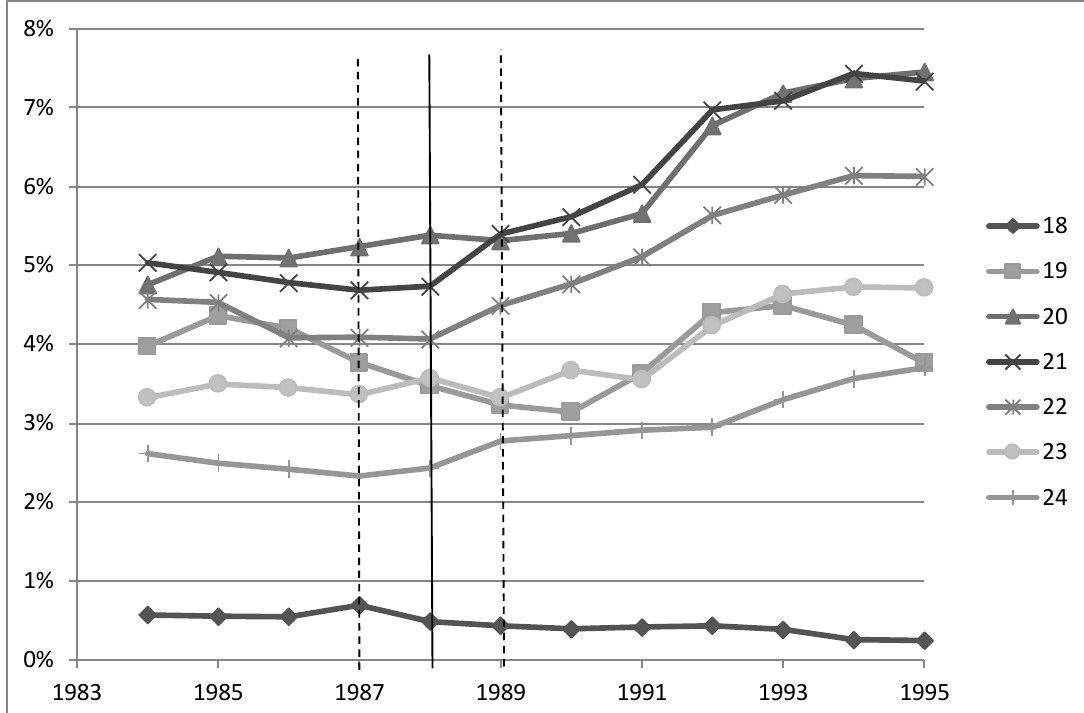
Fraction of men enrolled in higher education by age groups, 18 to 24 years of age, from 1984 to